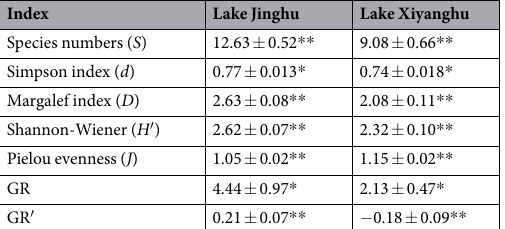
Table 2. Annual average values of taxon-based indices ( ± SE) [species number ( S ), Simpon index ( d ), Margalef index ( D ), Shannon-Wiener index, ( H ′ ) Pielou evenness index ( J )] and trait-based indices (GR and GR ′ ) of the